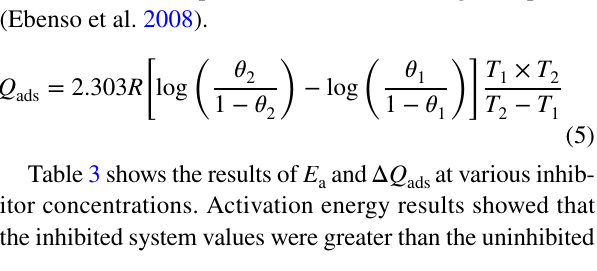
Table 3 Thermodynamics adsorption parameters of Gongronema lat- ifolium methanol extract Concentration of inhibition (%w/v)